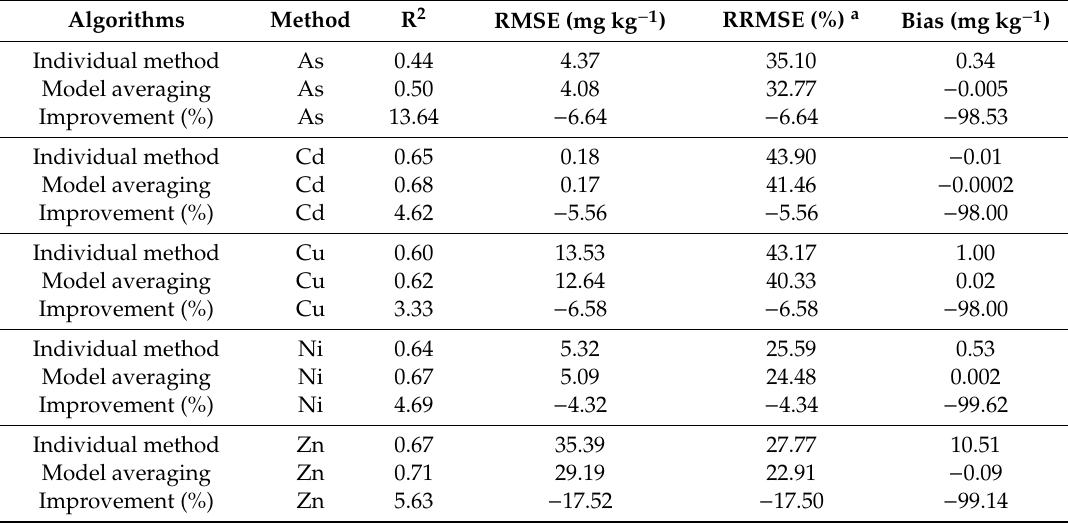
Table 4. Accuracy parameters of PTEs maps obtained by an optimized individual method and model